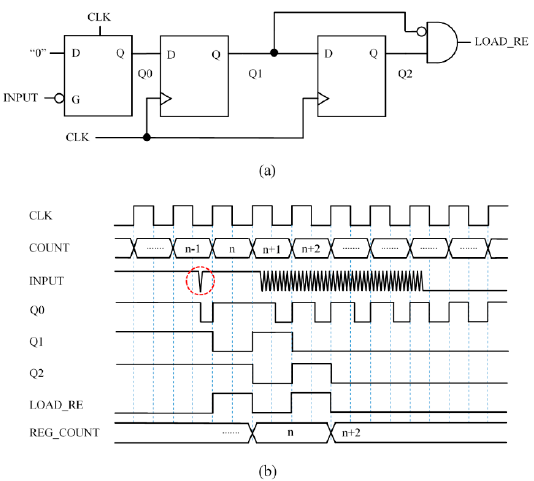
Figure 8. Capture Module 4—Circuit based on front end interface with latch robust against spikes: ( a ) circuit and ( b ) chronogram.